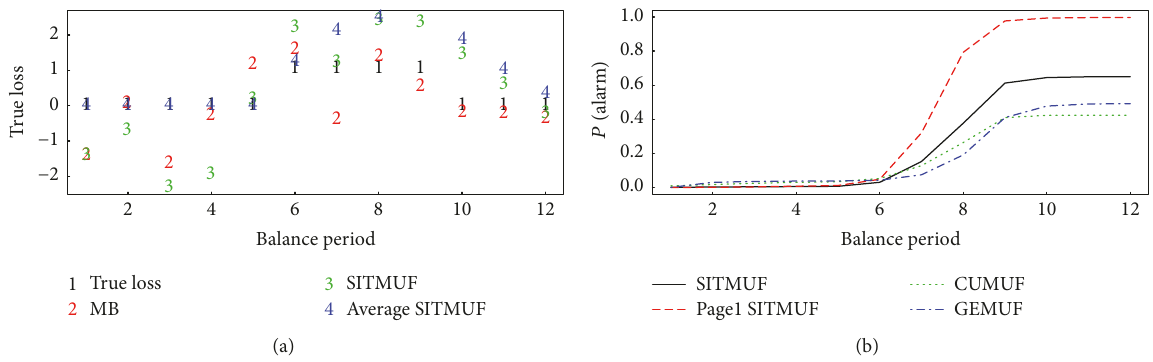
Figure 5: For Σ = Σ 1 , (a) the true loss, MB, SITMUF, and average SITMUF over all simulations versus balance period and (b) the alarm probability versus balance period (10 5 simulations) for SITMUF, Page1 SITMUF, CUMUF, and GEMUF.